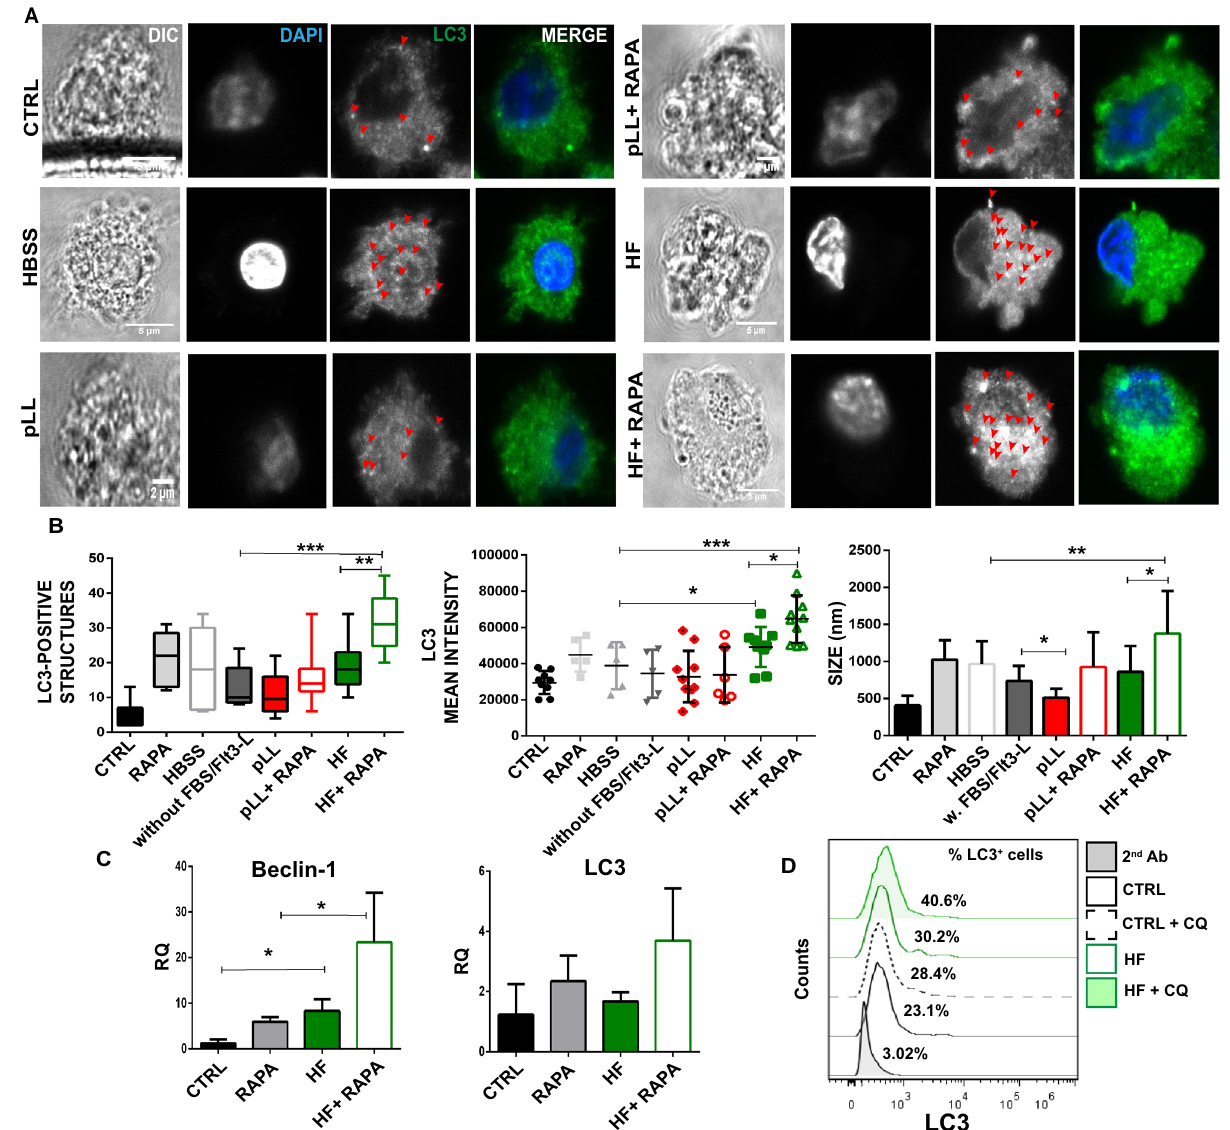
Figure 6. Hydatid fluid enhances the number of LC3-positive structures in BMDCs. ( A ) Confocal images of BMDCs (1 × 10 6/ ml) stimulated during 18 h with pLL or HF from E. granulosus in presence or absence of (20 nM) rapamycin. Cells culture without stimulation (CTRL), with rapamycin alone (RAPA), in starvation condition (HBSS) and without grown factors (without FBS/FlT3-L) were used as controls. Cells were stained with specific antibody for LC3 (green), and cell nuclei were stained with DAPI (blue). Scale bar 5 µm. Arrows indicate positive LC3 dotted structures in the cell cytoplasm. ( B ) Bar graphs show number, MFI and size of LC3 + structures ± SEM of different cells in a representative experiment of three independent experiments (one-way ANOVA test ****p < 0.0001 and Tukey post hoc test, *p < 0.05, **p < 0.01, ***p < 0.001 pLL or HF-stimulated cells vs control without FBS/FlT3-L). ( C ) Gene expression of Beclin 1 and LC3 were evaluated from isolated mRNA by quantitative PCR (relativized to the expression of GAPDH mRNA). Results are the mean ± SEM of three experiments performed in duplicate (one-way ANOVA test **p < 0.01 and Tukey post hoc test *p < 0.05 vs controls or when it is indicated stimulated-BMDCs vs rapamycin-treated BMDCs). ( D ) Cell permeabilization allows quantification of LC3 II-containing autophagosome fluorescence by FACS. A representative histogram of untreated-BMDCs, HF-stimulated or treated with CQ for 4 h shows mean intensity fluorescence and percentage of LC3 +